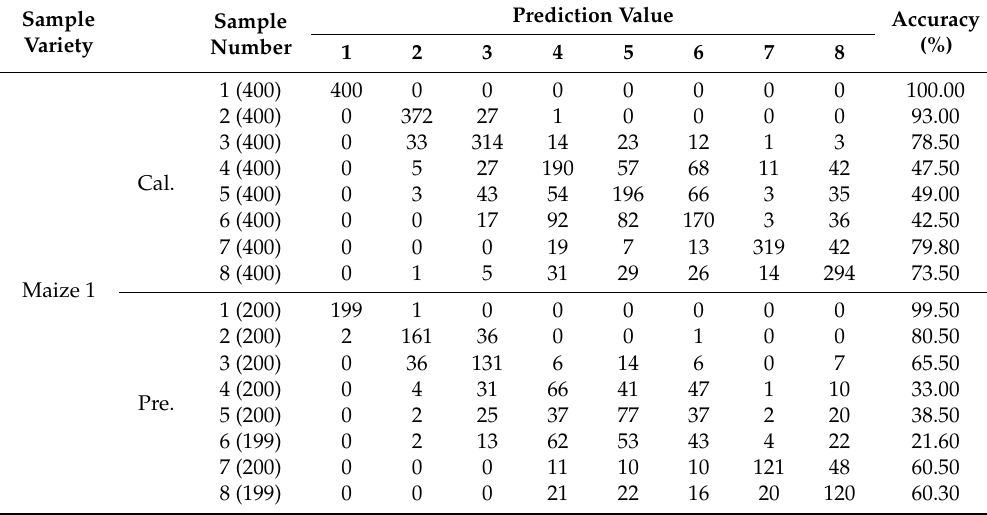
Table 6. Confusion matrix of SVM models using optimal wavelengths selected by second-order derivative